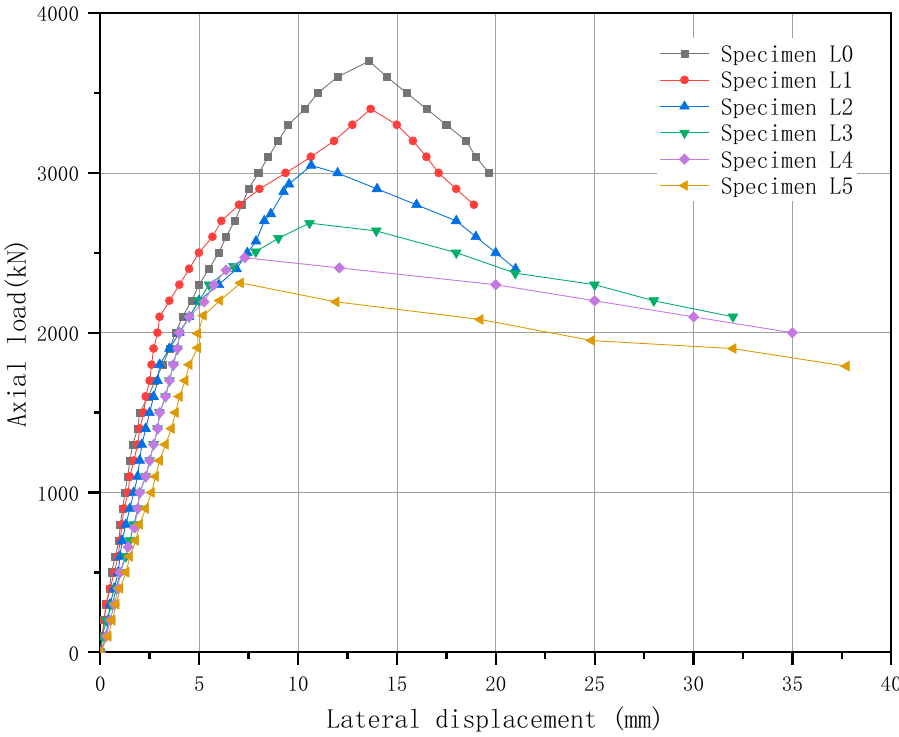
Figure 5. Axial load–lateral deformation curves of composite slender columns, measured at mid- height.